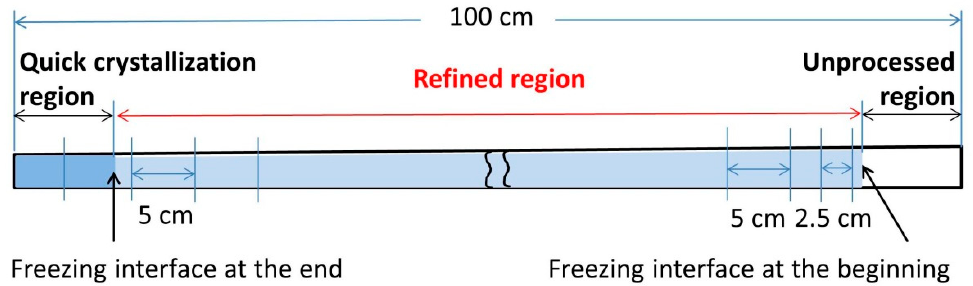
Figure 3. The form of the sample after refinement and the positions used for impurity concentration analysis.